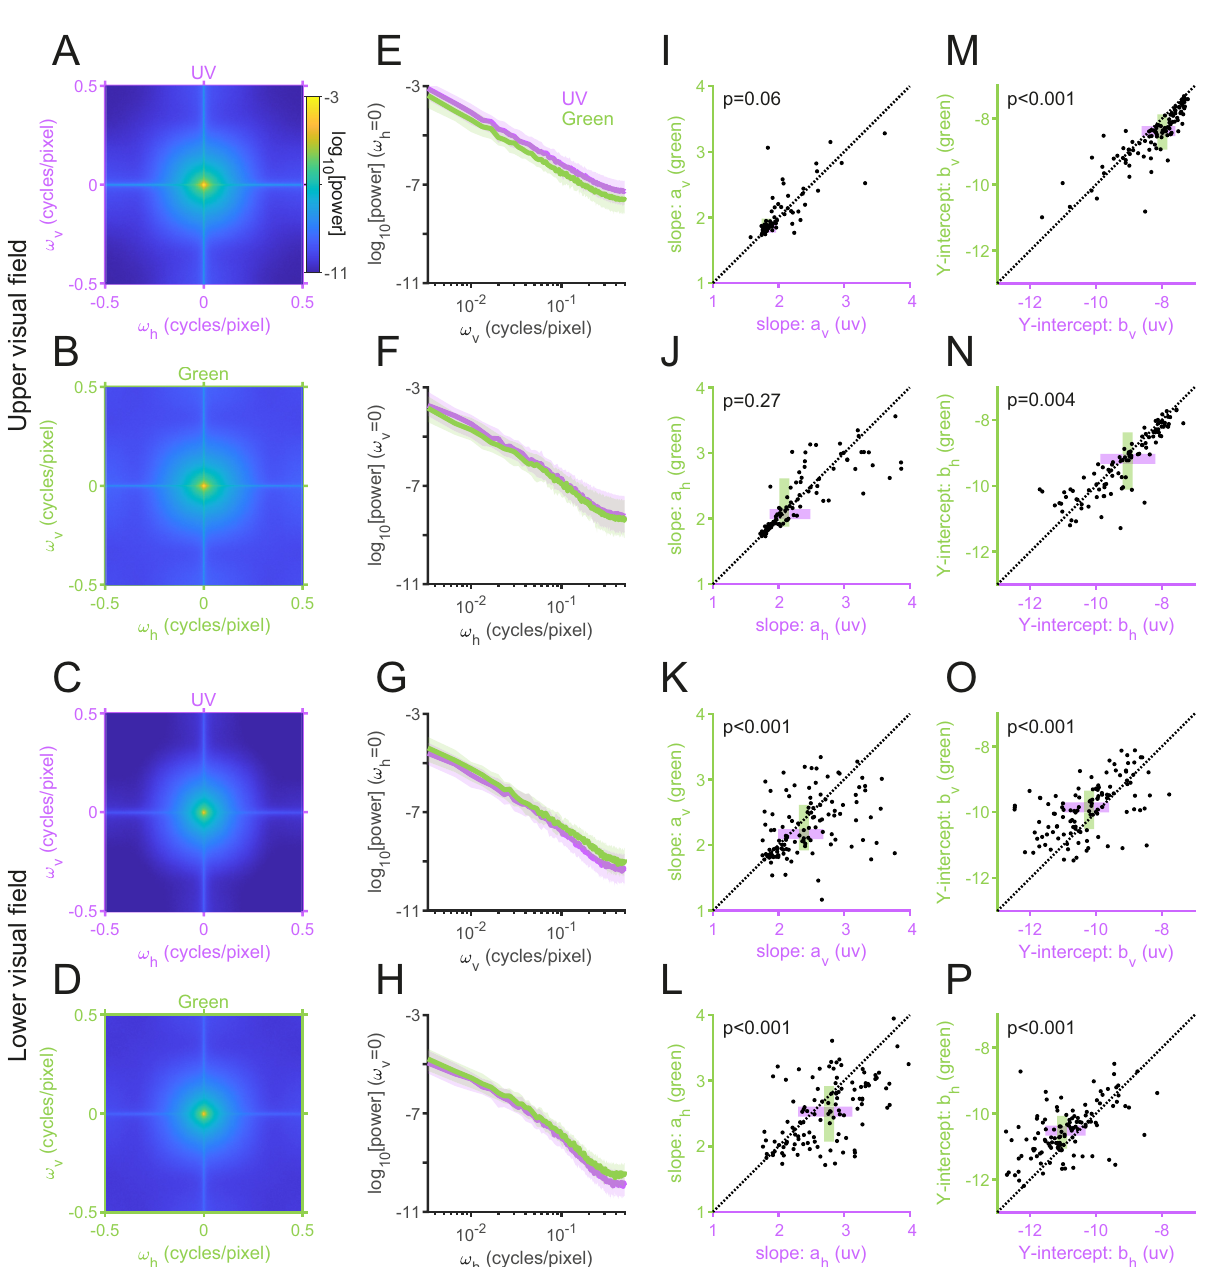
Fig 5. Power spectrum of the “mouse-view” natural images. (A–D) The average power spectra of the upper (A,B) and lower (C,D) visual field images for the UV (A,C) and Green (B,D) channels. (E–H) The power spectra in the vertical (E,G) and horizontal (F,H) directions (median and interquartile range) for the upper (E,F) and lower (G,H) visual field images. (I–M) The slope ( a ; I–L) and Y-intercept ( b ; M–P) parameters of the power function b / ω a in the log-log space fitted to the power spectra of each image in the vertical (I,K,M,O) and horizontal (J,L,N,P) directions. For the upper visual field images (I,J,M,N), the UV channel has significantly larger b (M,N) but comparable a (I,J) values than the Green channel. For the lower field images (K,L,O,P), in contrast, the Green channel has significantly larger b (O,P) and smaller a (K,L) values than the UV channel. P -values are obtained from